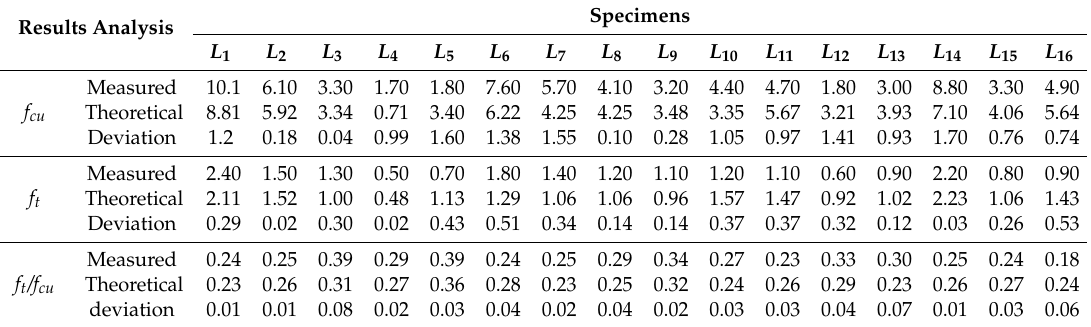
Table 9. Measured values and theoretical values of compressive strength and flexural